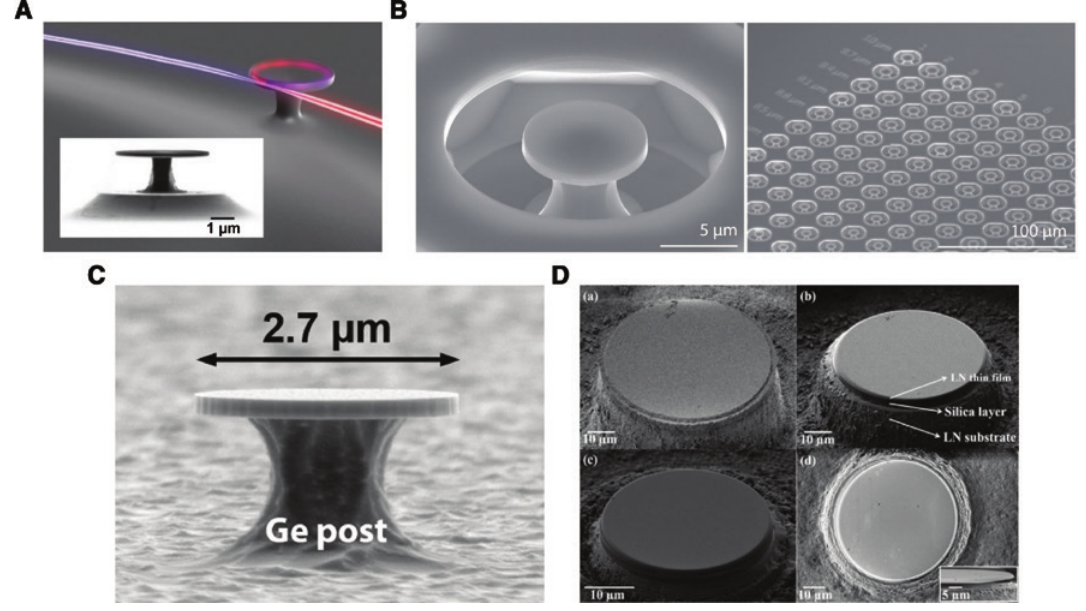
Figure 8: Materials for optical microdisk resonators. (A) SEM image of a GaAs microdisk and depiction of the fibre-taper-coupling-based second-harmonic generation. Reprinted from [86]. (B) SEM images of a single monolithic diamond microdisk and an array of such structures. Adapted from [87]. (C) SEM micrograph of a pseudo- morphic Ge/Ge Sn /Ge quantum-well microdisk with a Ge post. Adapted from [88]. (D) SEM micrographs for lithium niobate microreso- 0.92 0.08 nators, showing post formation via femtosecond laser ablation, two differently sized posts after focused ion beam milling, and the final product post-chemical etching and annealing, respectively. Reprinted from